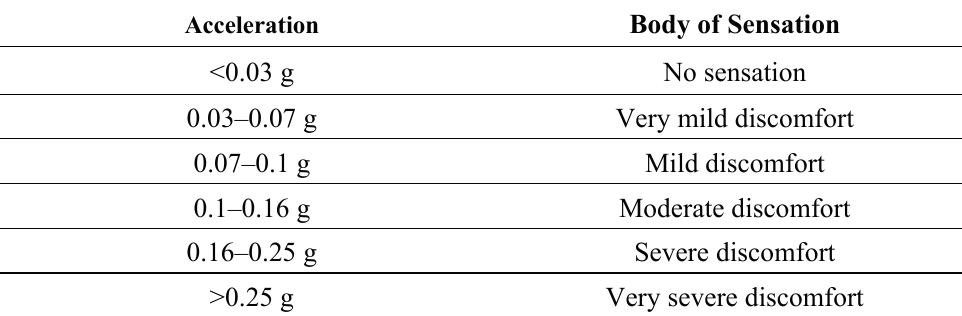
Table 2. Effects of vibration on people as defined by the International Standard Organization (ISO). These data were obtained from ISO 2631-1 (1997) as supported and adopted by the Taiwan High-Speed Rail to limit the vibration and acceleration for safety aspects. The health, comfort, perception, and motion of passengers are also